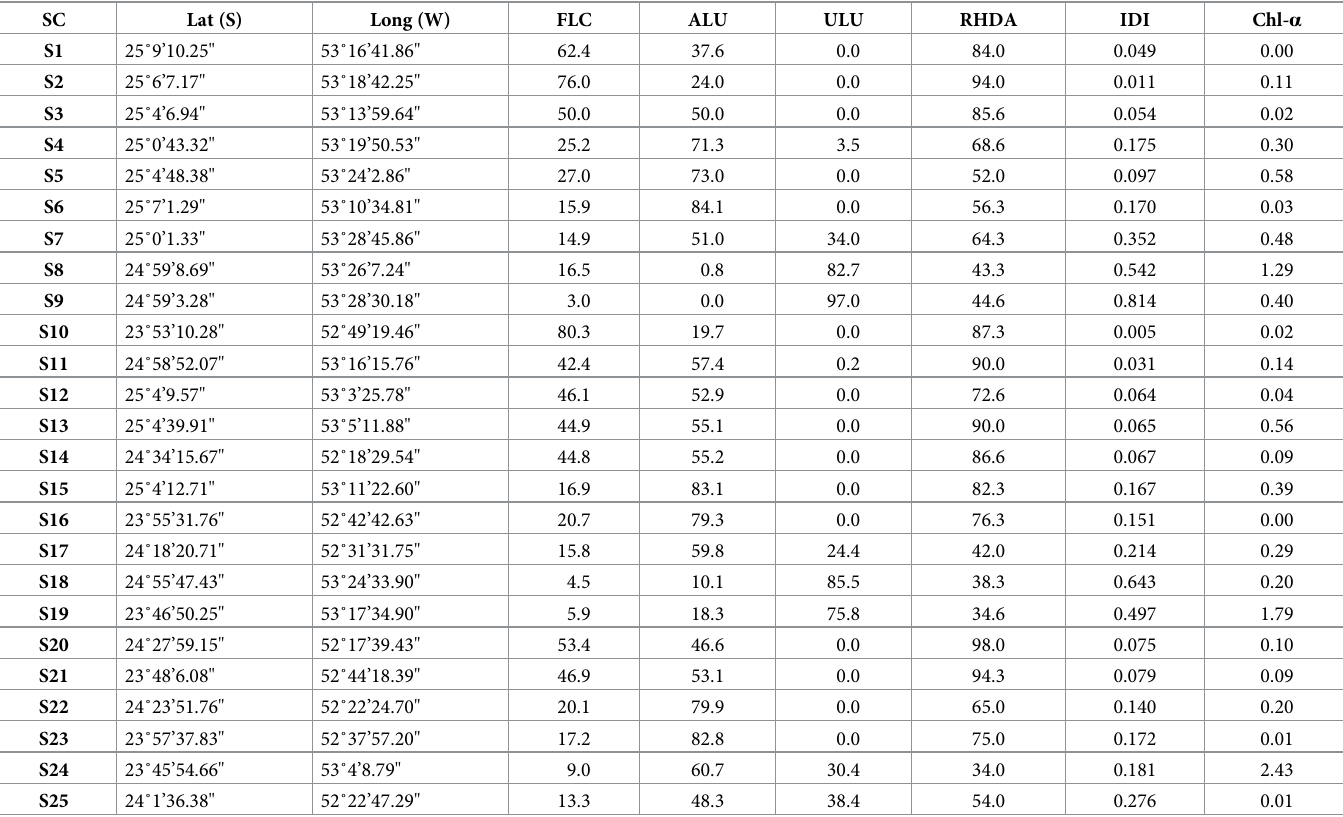
Table 1. Characteristics of the sampled